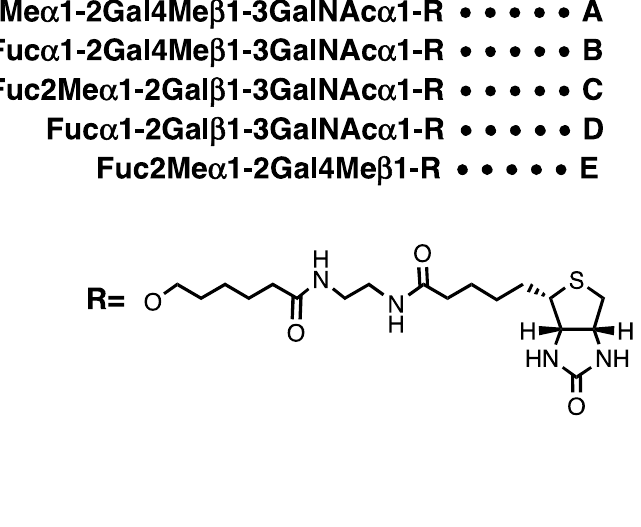
Figure 2. Structures of target compounds A – E